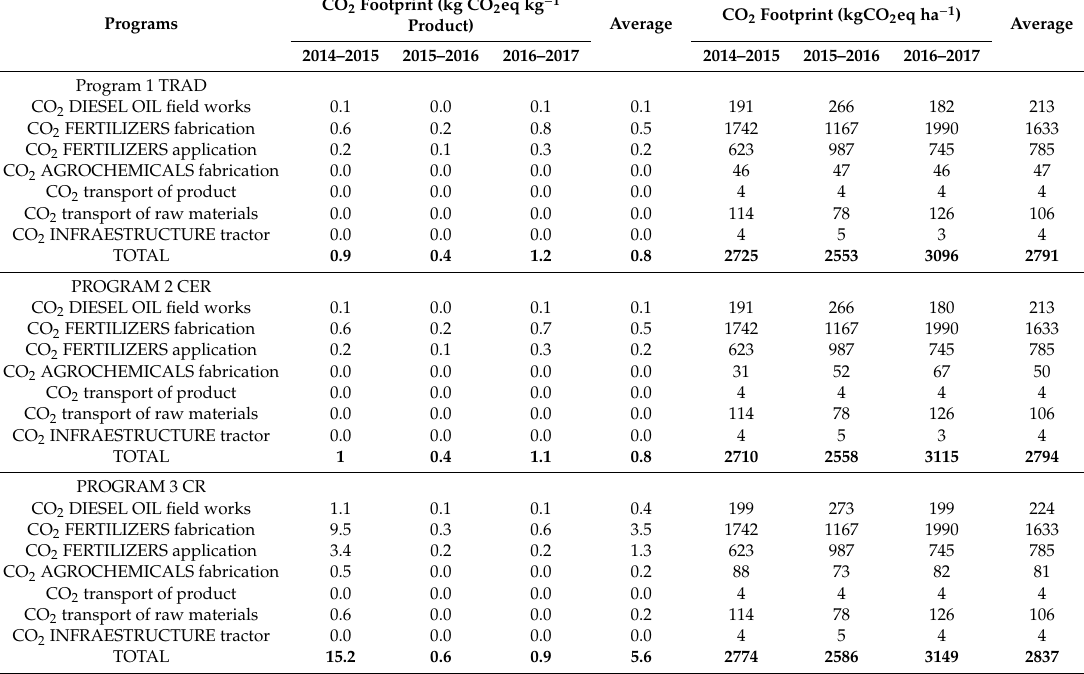
Table A1. CO 2 footprint (kg CO 2 -eq kg − 1 product and kg CO 2 - eq ha − 1 ) for each program along the three growing